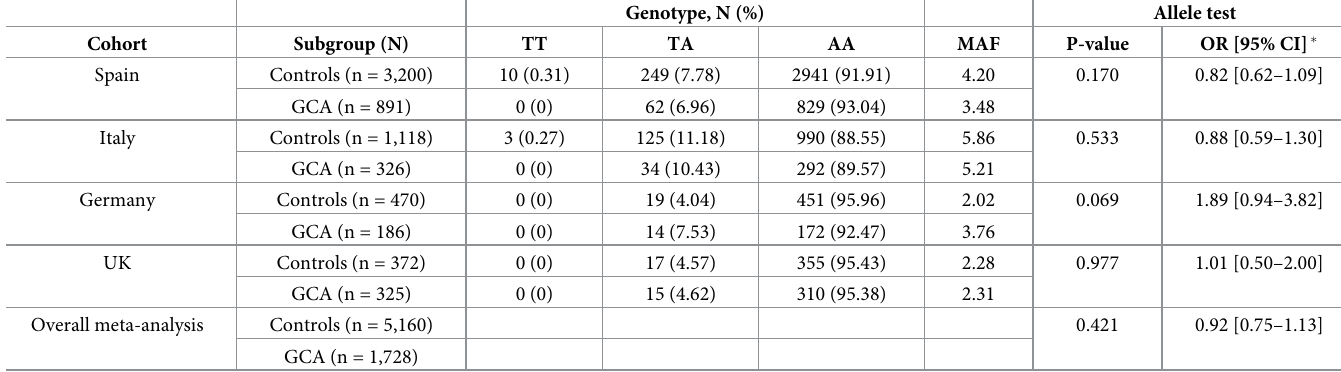
Table 2. Association analysis of the TNFSF13B rs374039502 variant in four independent GCA cohorts and meta-analysis.